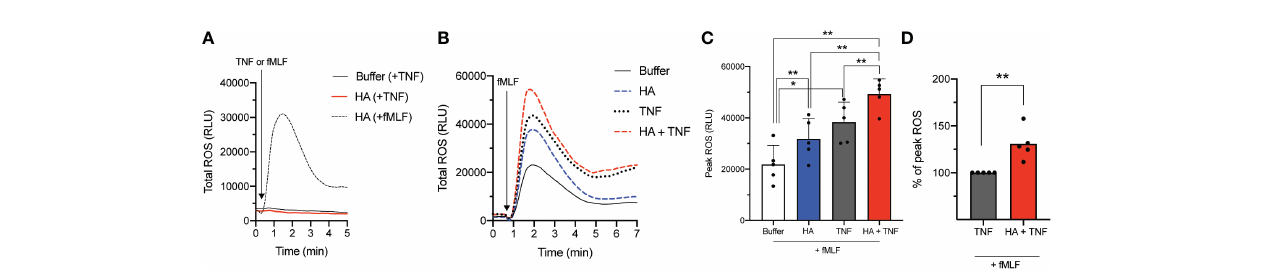
FIGURE 2 NADPH oxidase-derived reactive oxygen species (ROS) release by co-primed neutrophils. (A) Total ROS release (y-axis, relative light units (RLU)) by neutrophils over time (x-axis, min) after priming in the absence (buffer) or presence of HA (200 m g/mL) followed by fMLF (100 nM) or TNF a (10 ng/mL). (B) Total ROS production (y-axis, RLU) by neutrophils over time (x-axis, min) after priming without (buffer) and with TNF a (10 ng/mL), HA (200 m g/ml), or HA with TNF a followed by the addition of fMLF (100 nM). Histogram is representative of 5 independent experiments. (C) Bar graphs show mean peak total ROS (+SD) for HA-, TNF a − , or HA+TNF a -primed cells (x-axis, RLU) after stimulation with fMLF (D) Peak total ROS (mean + SD) in co-primed neutrophils (HA + TNF a ) is presented as % of peak total ROS relative to the response of TNF a -primed neutrophils to fMLF, n = 5. Statistical analysis was performed using repeated measures one-way ANOVA with Sidak ’ s multiple comparison test (C, D) ; *p < 0.05, **p <